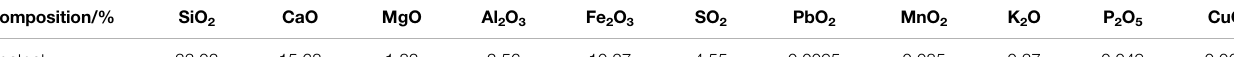
TABLE 2 | Composition of the main elements of the unclassi fi ed tailings (%).